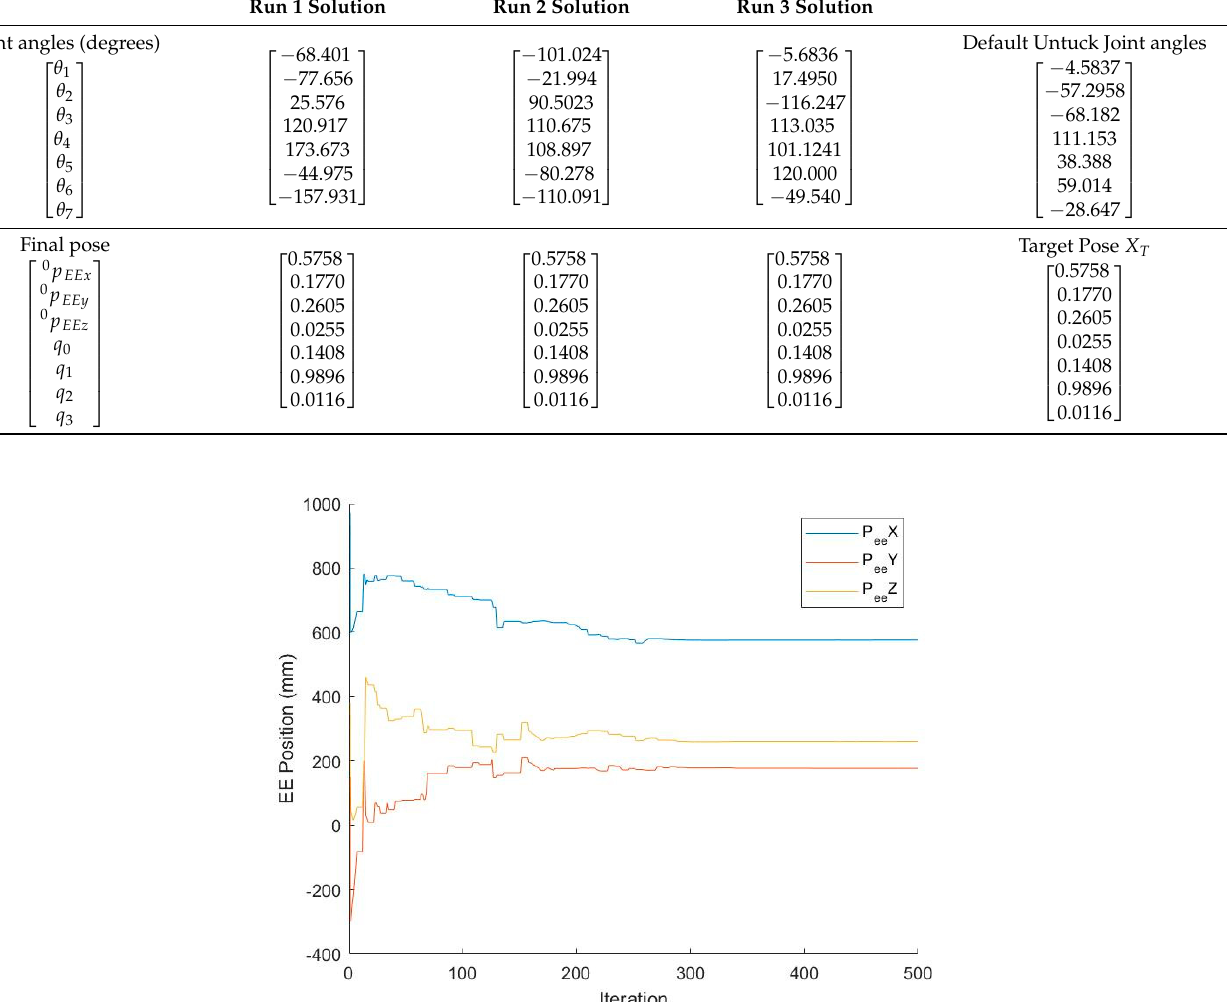
Table 2. Results of three runs with Target Pose at Baxter’s Untuck Configuration. Run 1 Solution Run 2 Solution Run 3 Solution